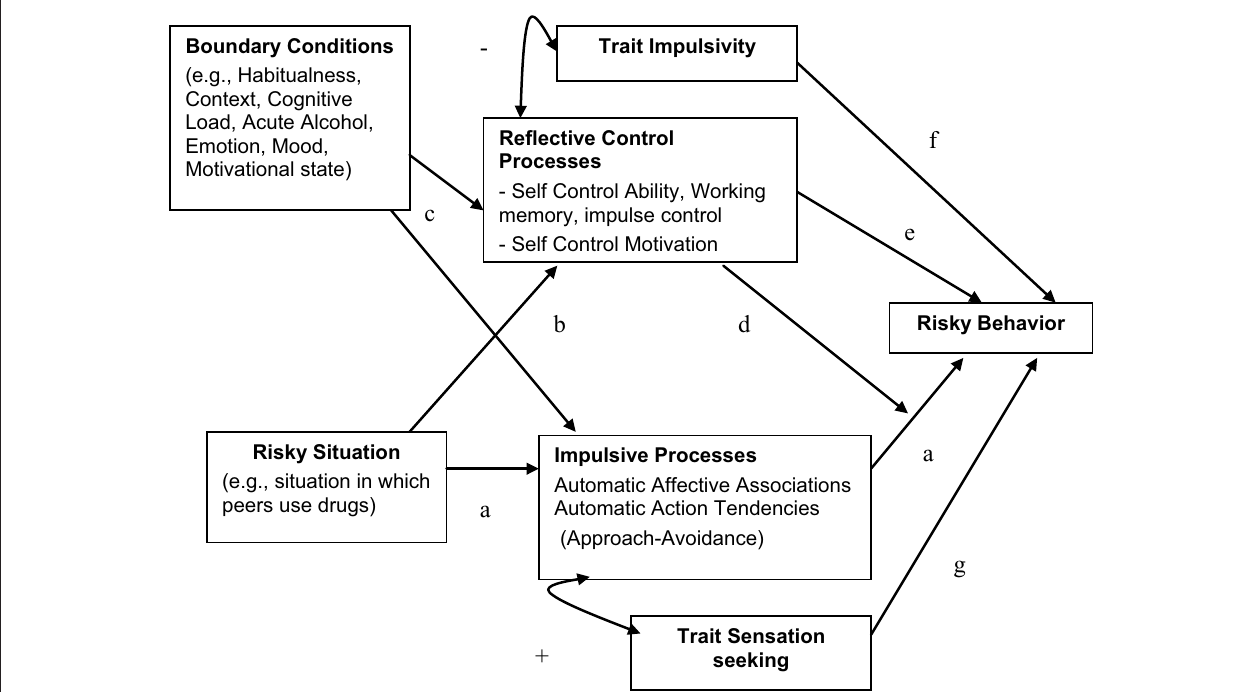
stronger, while the reflective processes get weaker. Pathway d represents the moderation of (behavior-specific) impulsive processes by reflective processes, as demonstrated in recent studies (see also Figure 1 ). Pathway e represents “rational risk taking”: after weighing pros and cons (reflective process), the risk is taken. Question addressed in the re-analyses presented here is whether individual differences in trait impulsivity can be viewed as a moderator, similar to executive control capacity or self-control, or whether it uniquely predicts risky behavior, independent of specific impulsive and reflective processes (pathway f). In addition, it is tested whether the moderated pathway of specific associations is robust, for controlling for trait impulsivity and sensation seeking (pathways f and